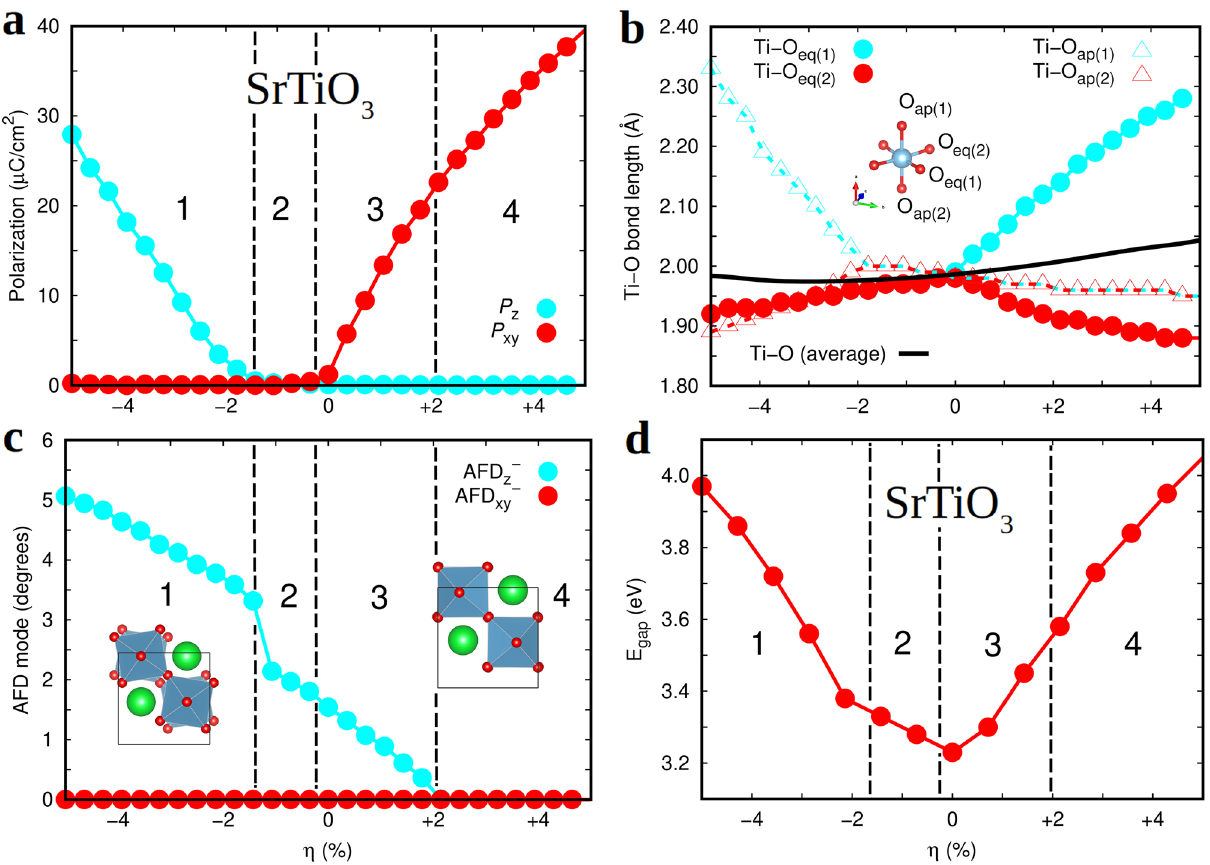
Figure 2. Physical properties of stoichiometric (001) SrTiO 3 thin films estimated with first-principles methods. ( a ) The electric polarization along the out-of-plane ( P z ) and in-plane ( P xy ) directions expressed as a function of expitaxial strain, η . ( b ) Different Ti–O bond lengths expressed as a function of epitaxial strain. ( c ) Antiphase out-of-plane ( AFD − z ) and in-plane ( AFD − xy ) antiferrodistortive O 6 rotations expressed as a function of epitaxial strain. ( d ) Energy band gap of (001) SrTiO 3 thin films estimated with the range-separated hybrid functional HSE06 45 on the geometries determined at the PBE+ U level. The vertical lines indicate different phase stability regions, namely, 1. I 4 cm , 2. I 4/ mcm , 3. Ima 2 and 4. Amm 2. The solid lines are simply guides for the